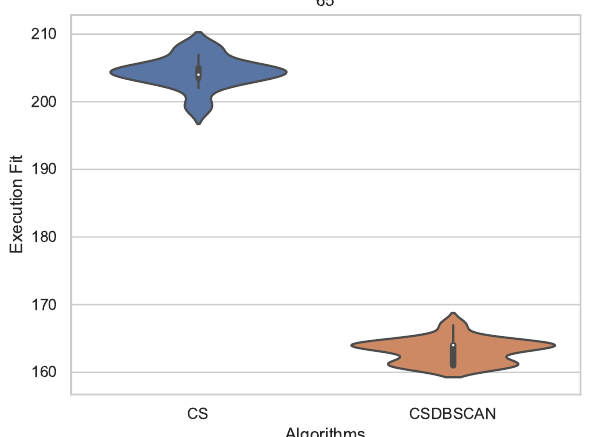
Figure 6. Instance 6.5 distribution.